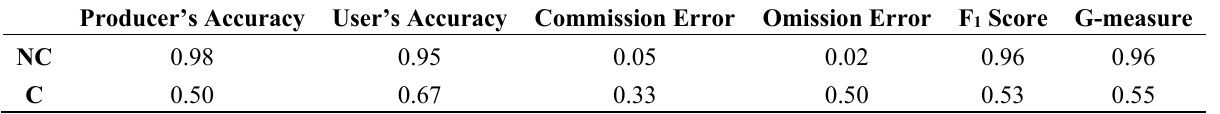
Table 2. Accuracy assessment of the C and NC